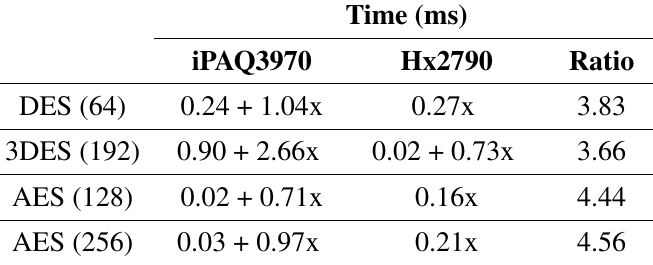
Table 3. Temporal costs of symmetric algorithms in a PDA